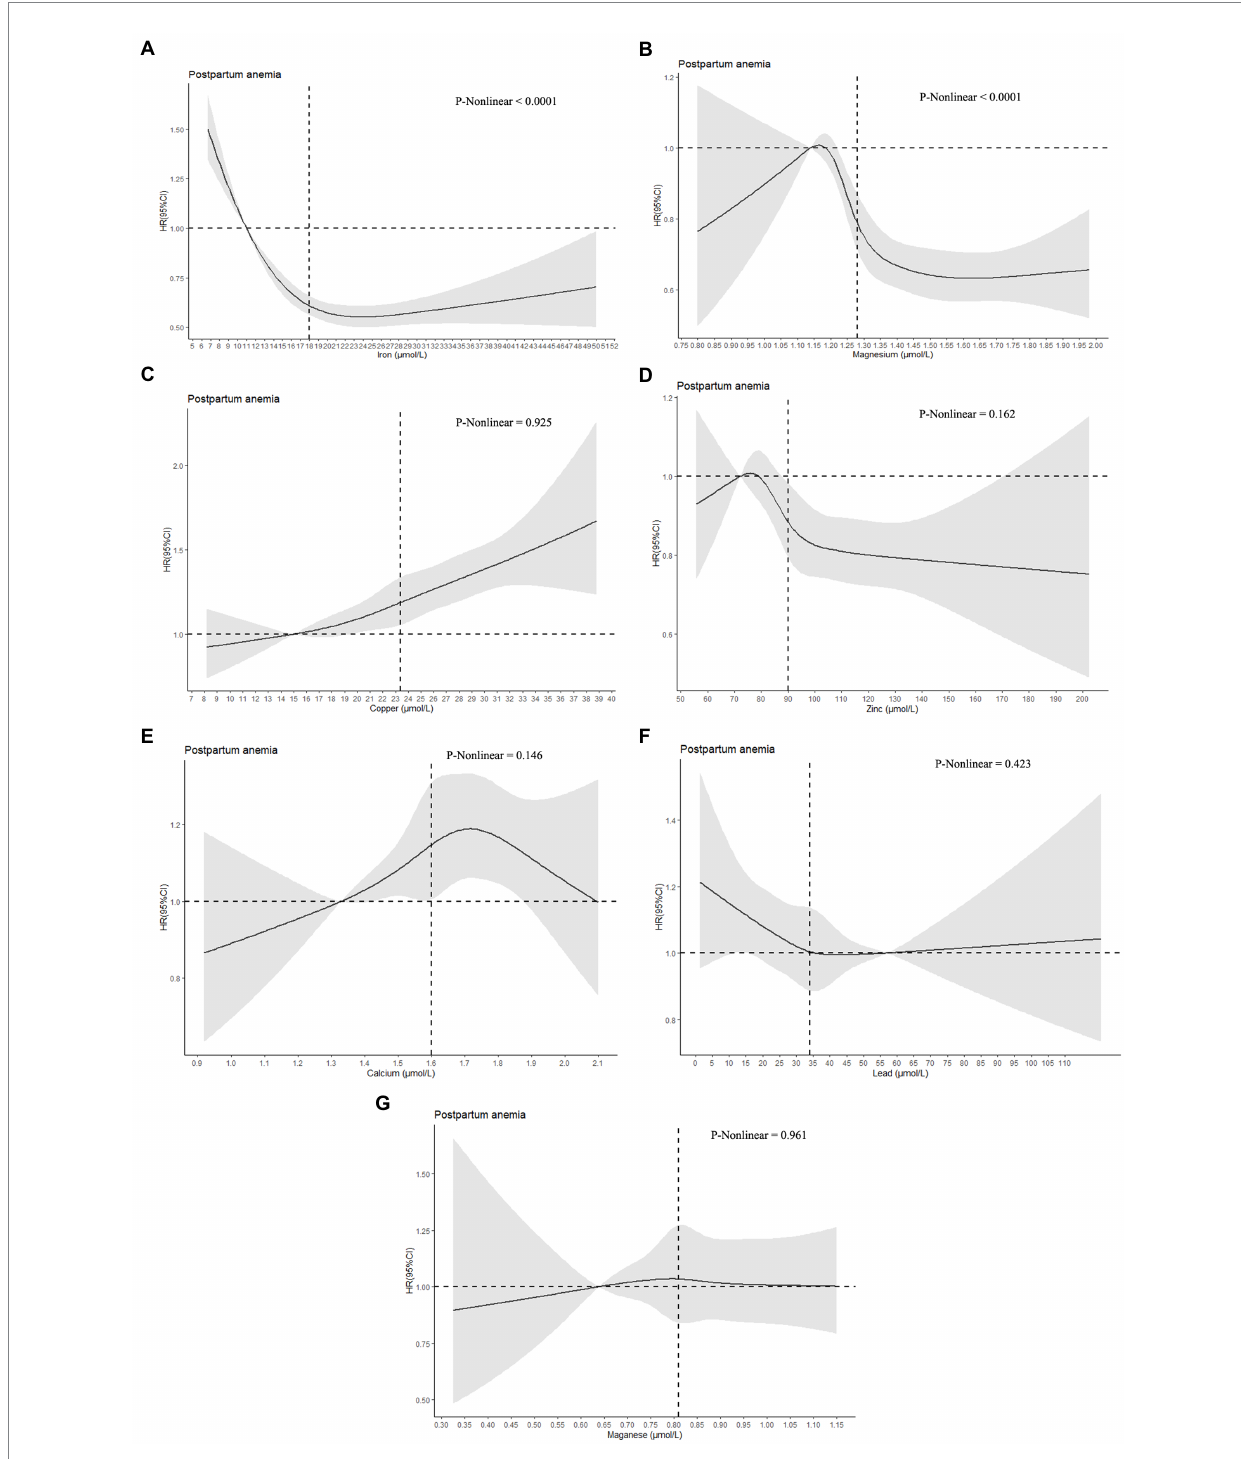
FIGURE 1 Dose–response associations between serum concentrations of metals and postpartum anemia. Analyses were performed by restricted cubic spline regressions (5 knots). The median concentrations of iron, magnesium, copper, zinc, calcium, and magnanese in Q1 were used as the reference values (HR = 1.00) for analyses of these species, while the median concentration of Pb in Q5 was assigned as the reference value (HR = 1.00) for this species. The vertical lines represent the median metal concentrations. Parts A-G represent the dose-response associations of iron, magnesium, copper, zinc, calcium, lead, and magnanese with postpartum